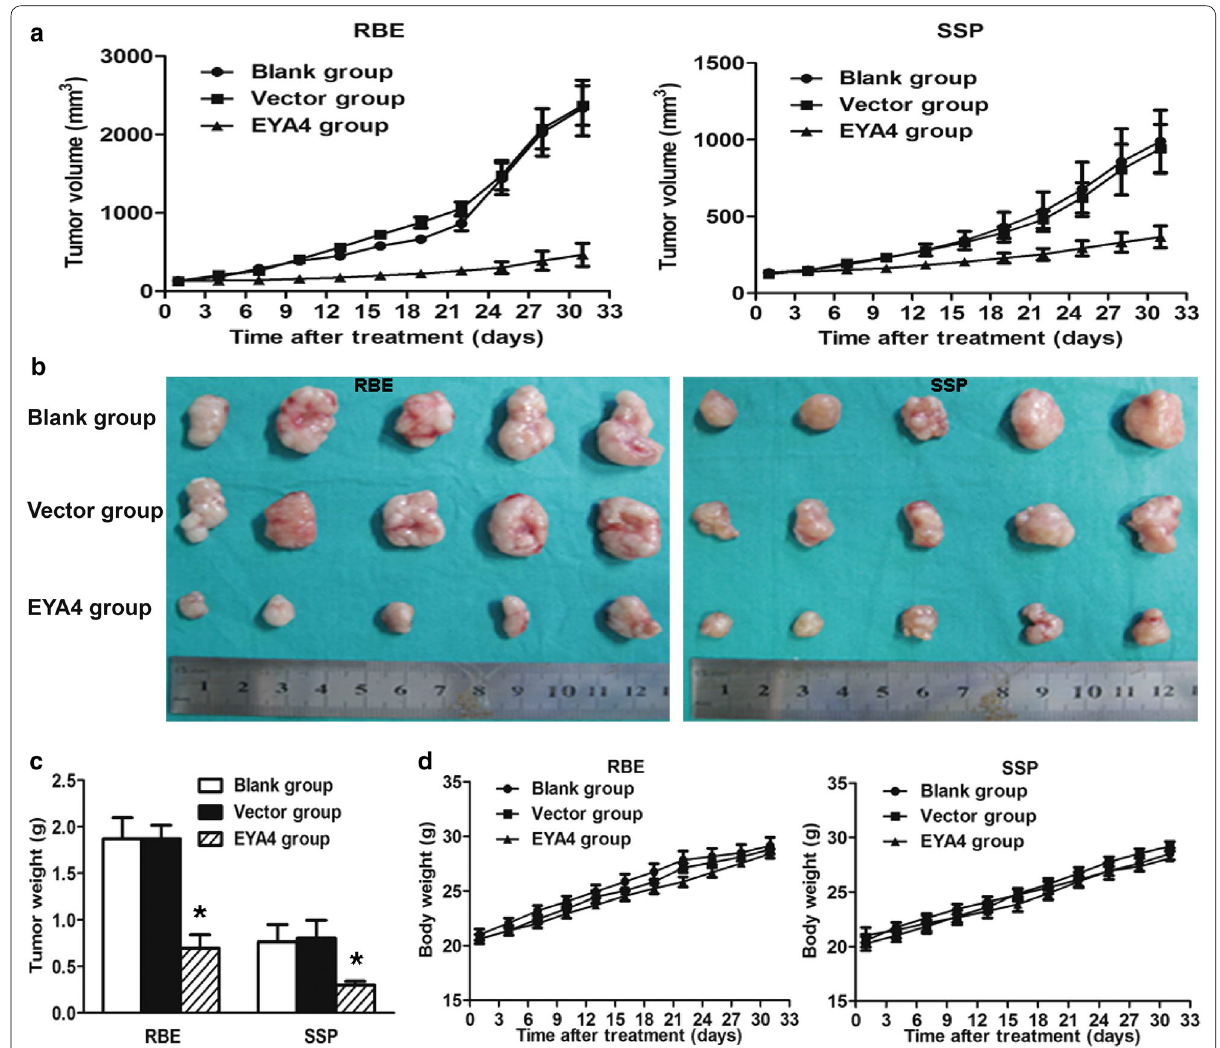
Fig. 4 Intratumoral injection of EYA4 ‑ expressing plasmids suppressed RBE‑ and SSP‑25‑derived xenograft tumor growth in vivo. a Intra‑tumoral injection of EYA4 plasmids (EYA4 group) led to slower tumor growth at nearly all examined time points compared with vector and blank groups ( P 0.001 and P 0.033, respectively); b After six treatments by intratumoral injection, the volume of tumors in the EYA4 group ( bottom ) was sig‑ = = nificantly smaller than those in the vector ( middle ) and blank groups ( top , P the EYA4 group were significantly smaller than those in vector and blank groups (* P effects of EYA4 ‑expressing plasmid treatment were evaluated by mice body weight, and no differences are observed among EYA4, vector and blank groups ( P 0.617 for RBE and P 0.924 for SSP, = =